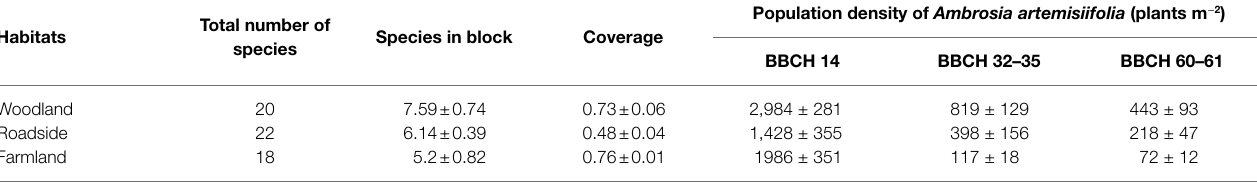
Values are means ± SE. BBCH classification criteria refer to Hess et al. (1997). BBCH 14, BBCH 32–35, and BBCH 60–61 are in the seedling stage, vegetative growth stage and reproductive growth stage of Ambrosia